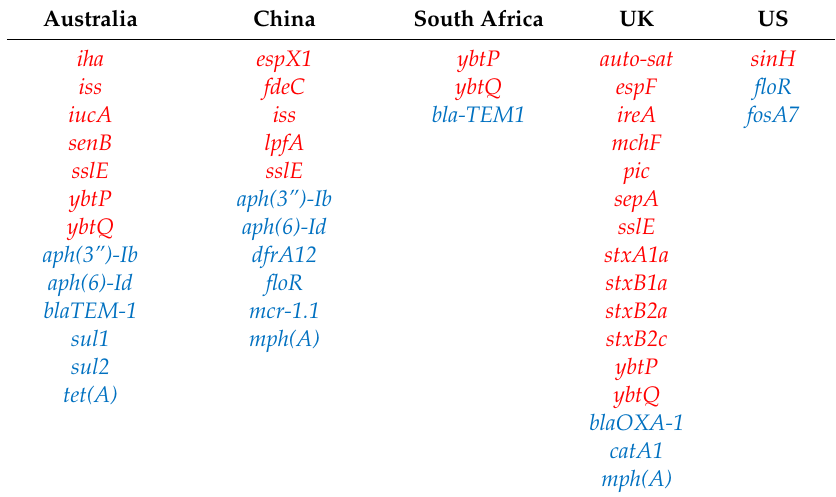
Figure 5. The result of hierarchical clustering of important virulence genes and antimicrobial resistance (AMR) genes in the US from samples between 2010 and 2020. Table 4. Virulence genes and AMR genes clustered in similar groups for each country, identified by hierarchical clustering (red—virulence genes; blue—AMR